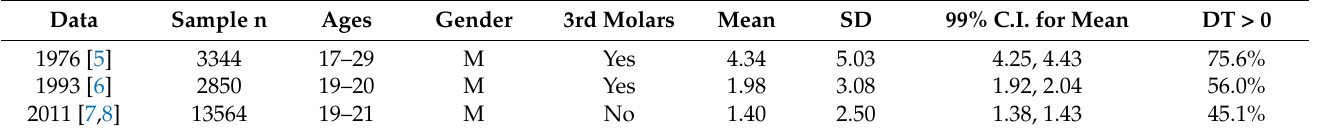
Table 1. Summary of previous cross sectional studies conducted on Finnish